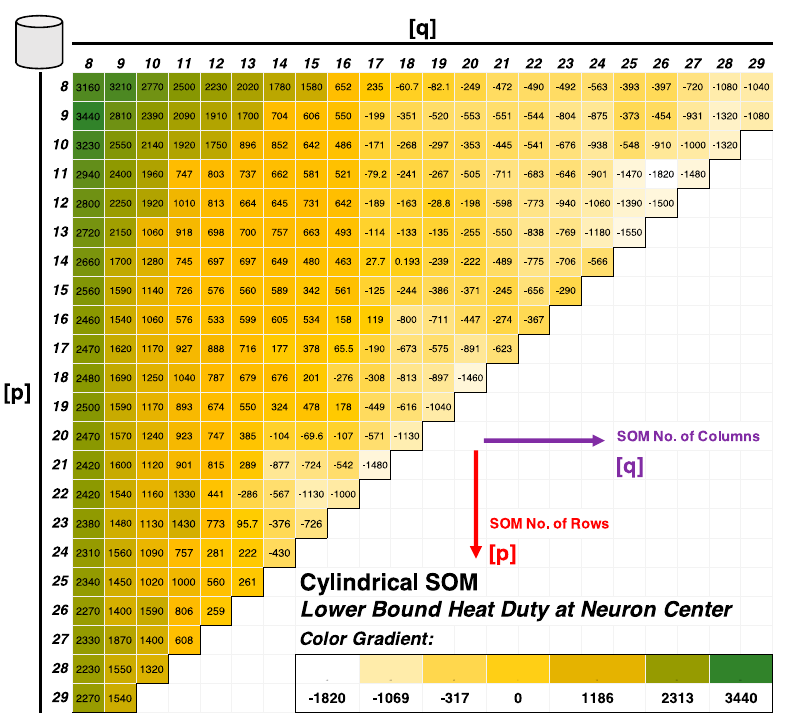
Figure 7. Lowest nominal value of the model variable ‘heat duty’ in a trained cylindrical SOM in hexagonal lattice at number of rows and number of columns of the SOM lattice.